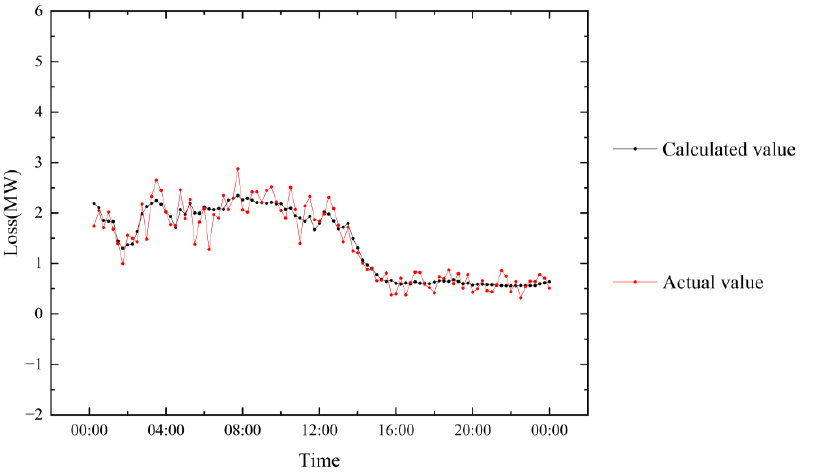
Figure 14. Result of cable loss calculation.